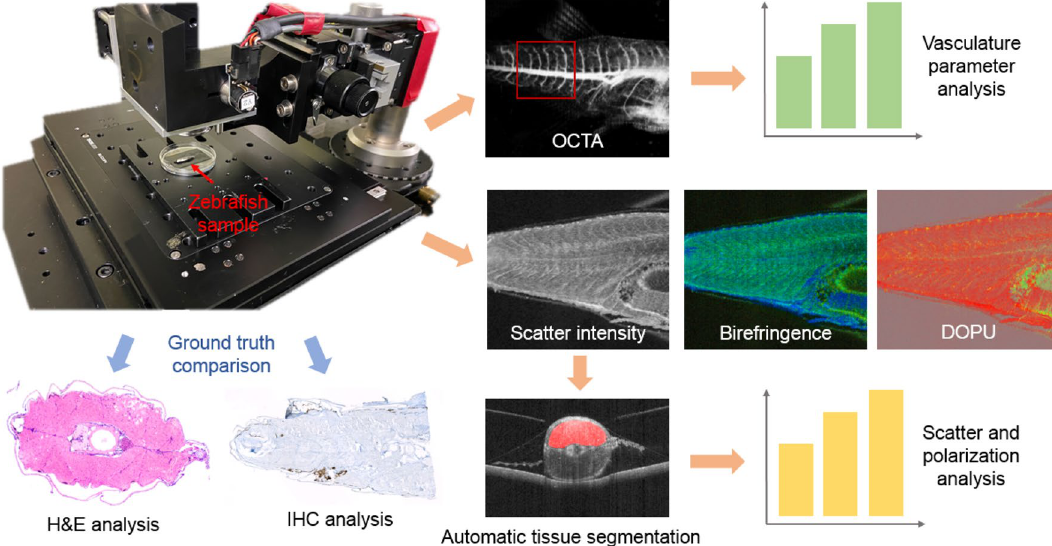
Figure 8. The data acquisition and processing steps with a photograph of the Jones-matrix OCT prototype. The scatter and polarization (birefringence and degree of polarization uniformity (DOPU)), and angiography (OCTA) data were analyzed. Quantitative analysis was performed based on an automatic tissue segmentation. As a ground truth histology analysis based on hematoxylin and eosin (H &E) and immunohistochemistry (IHC) staining was